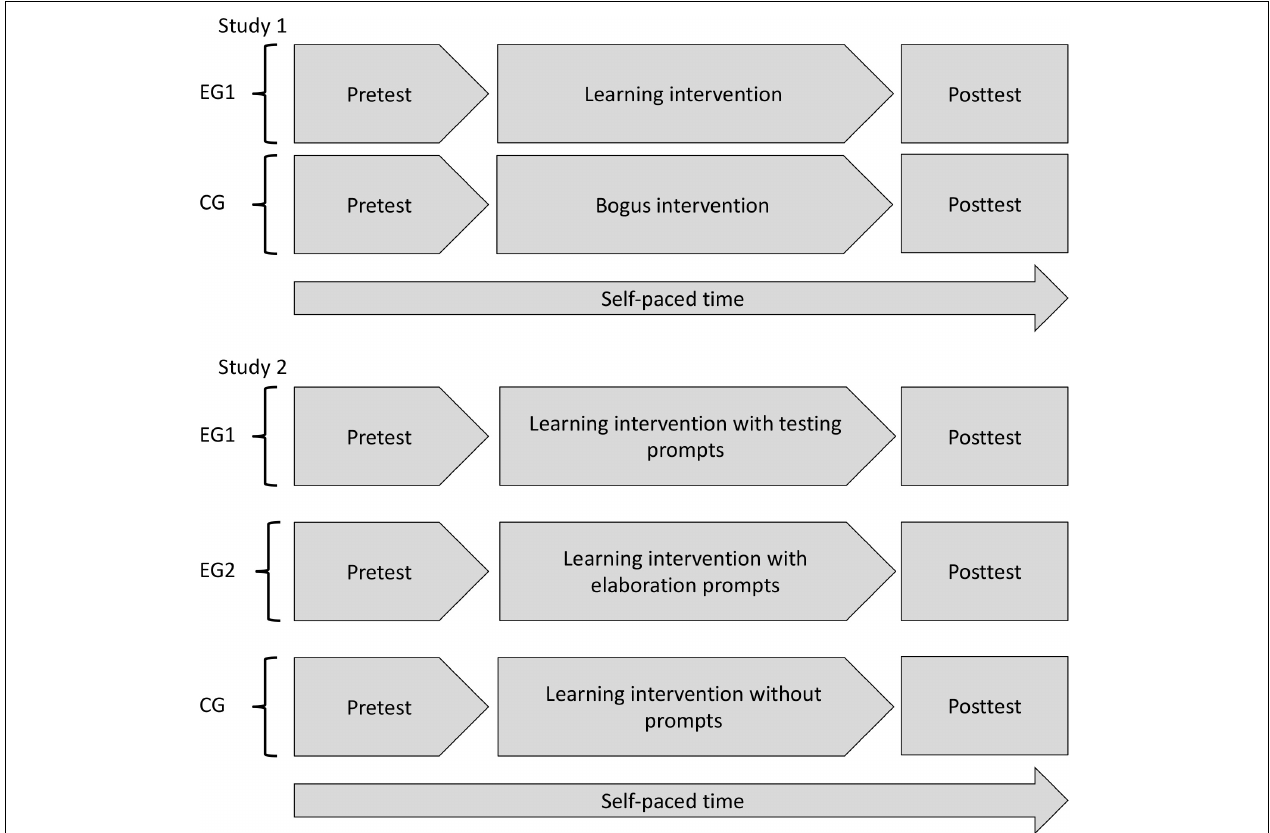
FIGURE 2 | Procedures in Study 1 (top panel) and Study 1 (bottom panel)